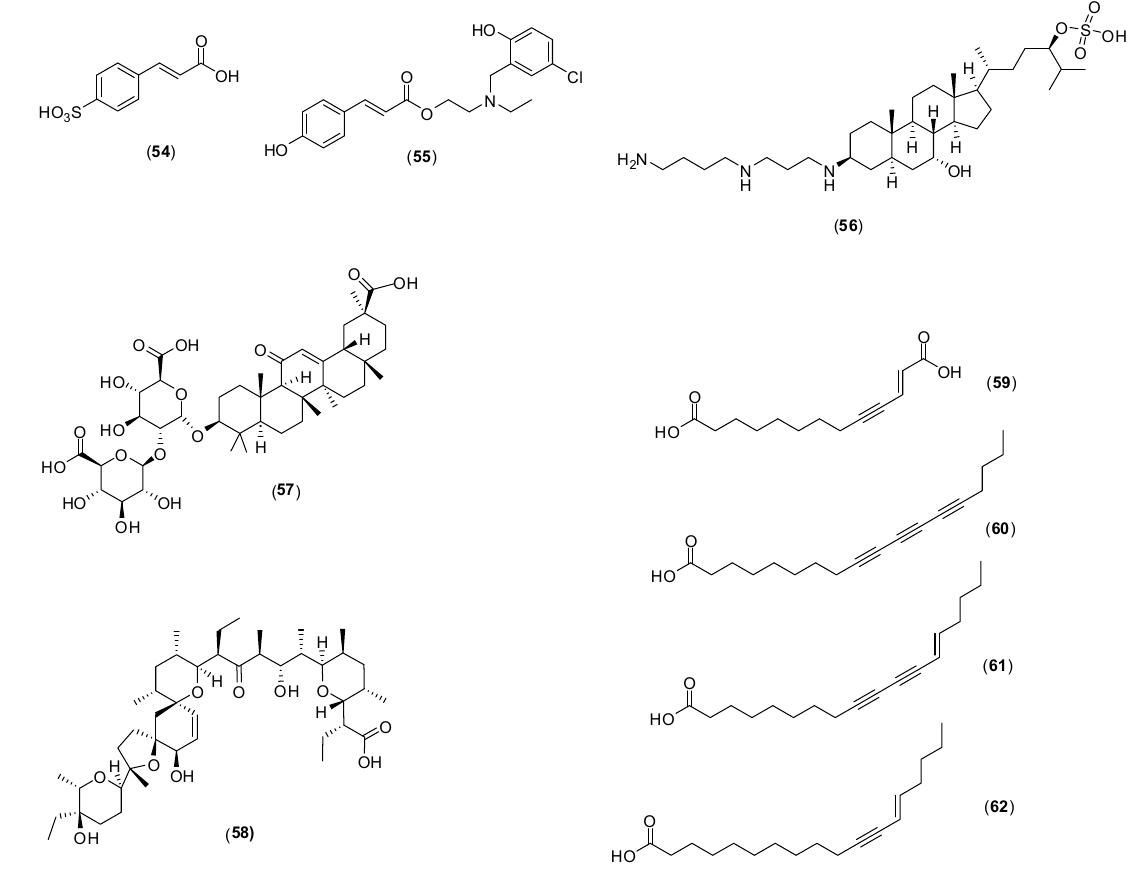
Table 5. Bioactivities determined for glycyrrhizin ( 58 ) against DENV-1-3. Virus